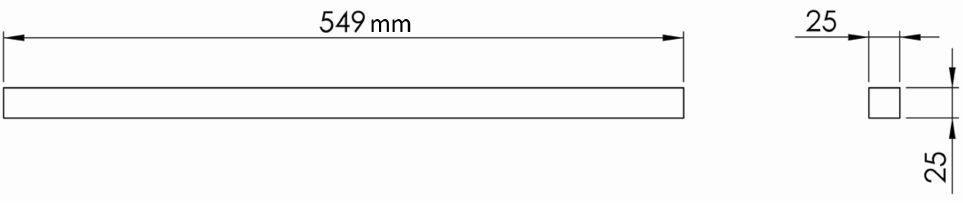
Figure 1. Dimension of a Norway spruce (Picea abies ( L. ) Karst.) sample. (unit: mm)